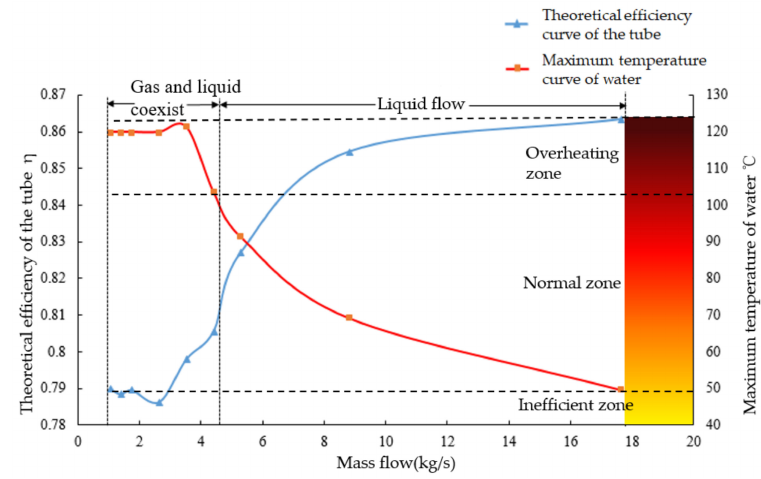
Figure 16. Theoretical e ffi ciency of the tube changes with flow